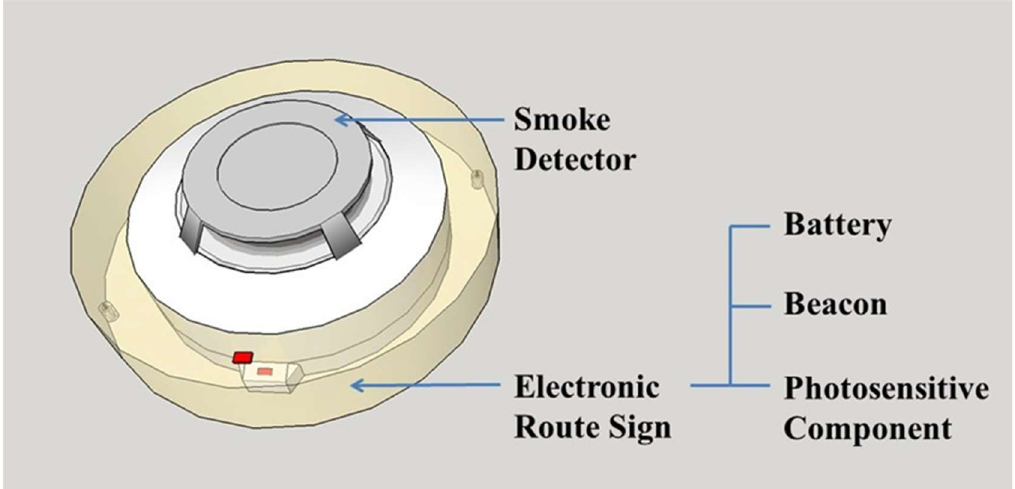
Figure 2. Diagram of a smoke detector fitted with an ERS.